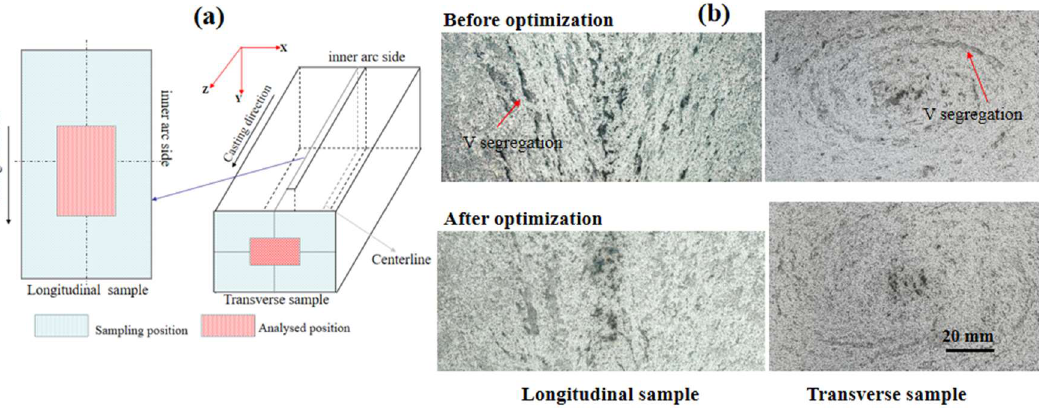
Figure 13. Schematic diagram of ( a ) sampling positions and ( b ) macrographs of etched samples.